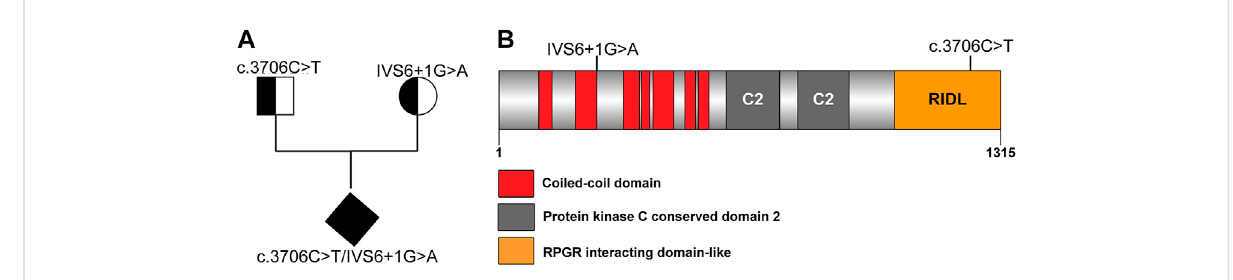
FIGURE 1 Novel RPGRIP1L mutationidenti fi edinanunbornfetus. (A) Pedigreeofthefamilycarrying RPGRIP1L mutations. (B) Schematicrepresentationor the RPGRIP1L mutations reported in RPGRIP1L